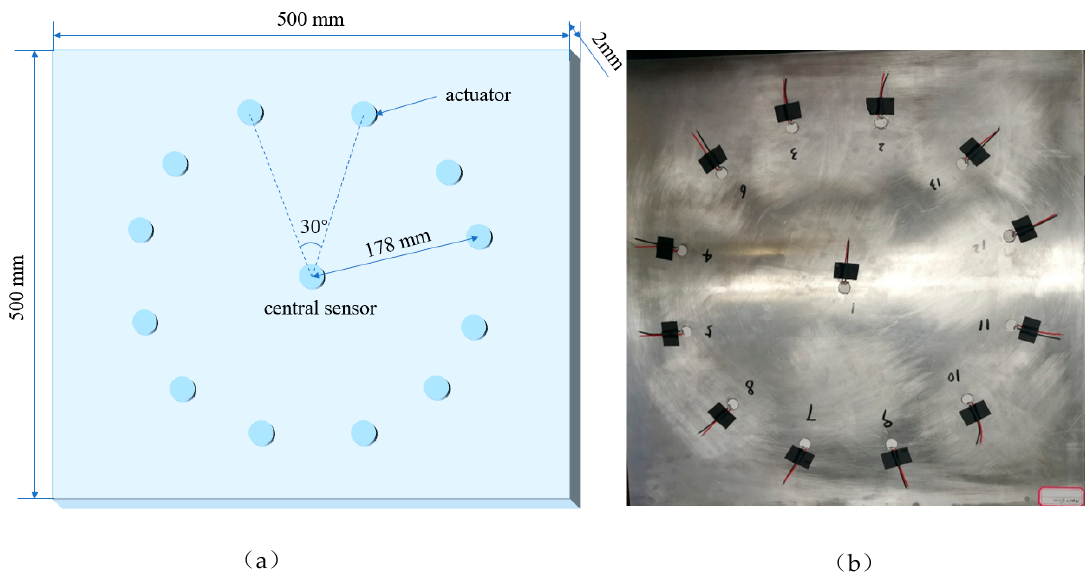
Figure 11. Layout of piezoelectric actuator / sensor on the aluminum plate: ( a ) layout design of piezoelectric elements; ( b ) actual placement of piezoelectric elements.